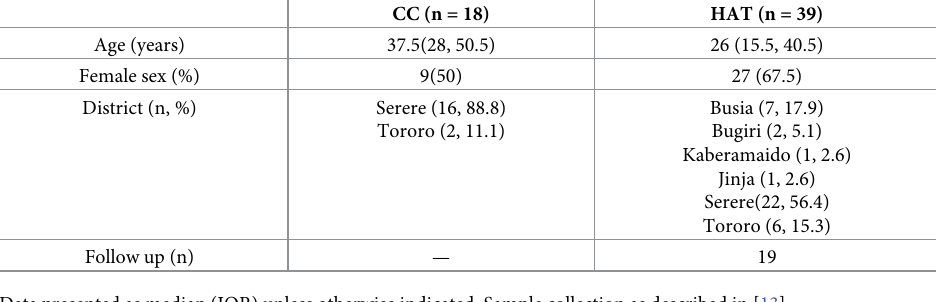
Table 1. (related to Fig 6). Demographics for HAT patients and endemic community controls.